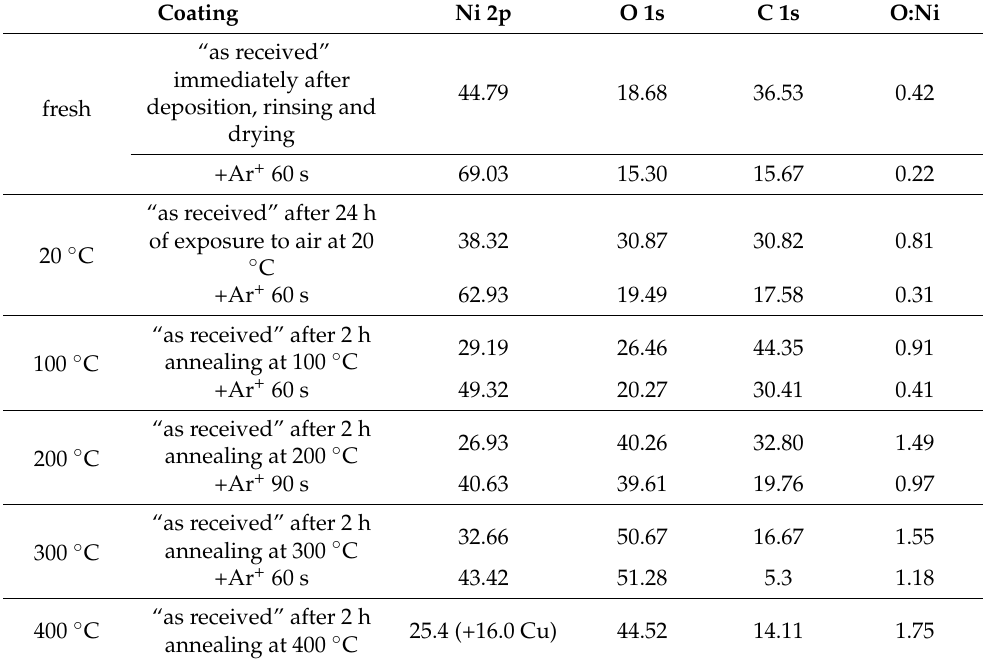
Table 2. Changes in chemical composition (at.%) of the outer surface of the as-deposited Ni coating and the Ni coatings after annealing for 2 h at: 100, 200, 300 and 400 ◦ C. The surface of nickel coatings was analyzed immediately after deposition plus annealing and after a gentle/mild Ar+ cleaning (1.5 keV, 2 µ A cm − 2 , 60 or 90